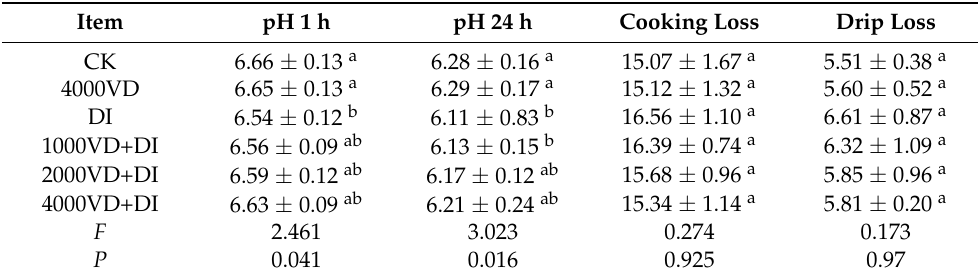
Table 6. Quality identification of the Wenchang chicken leg